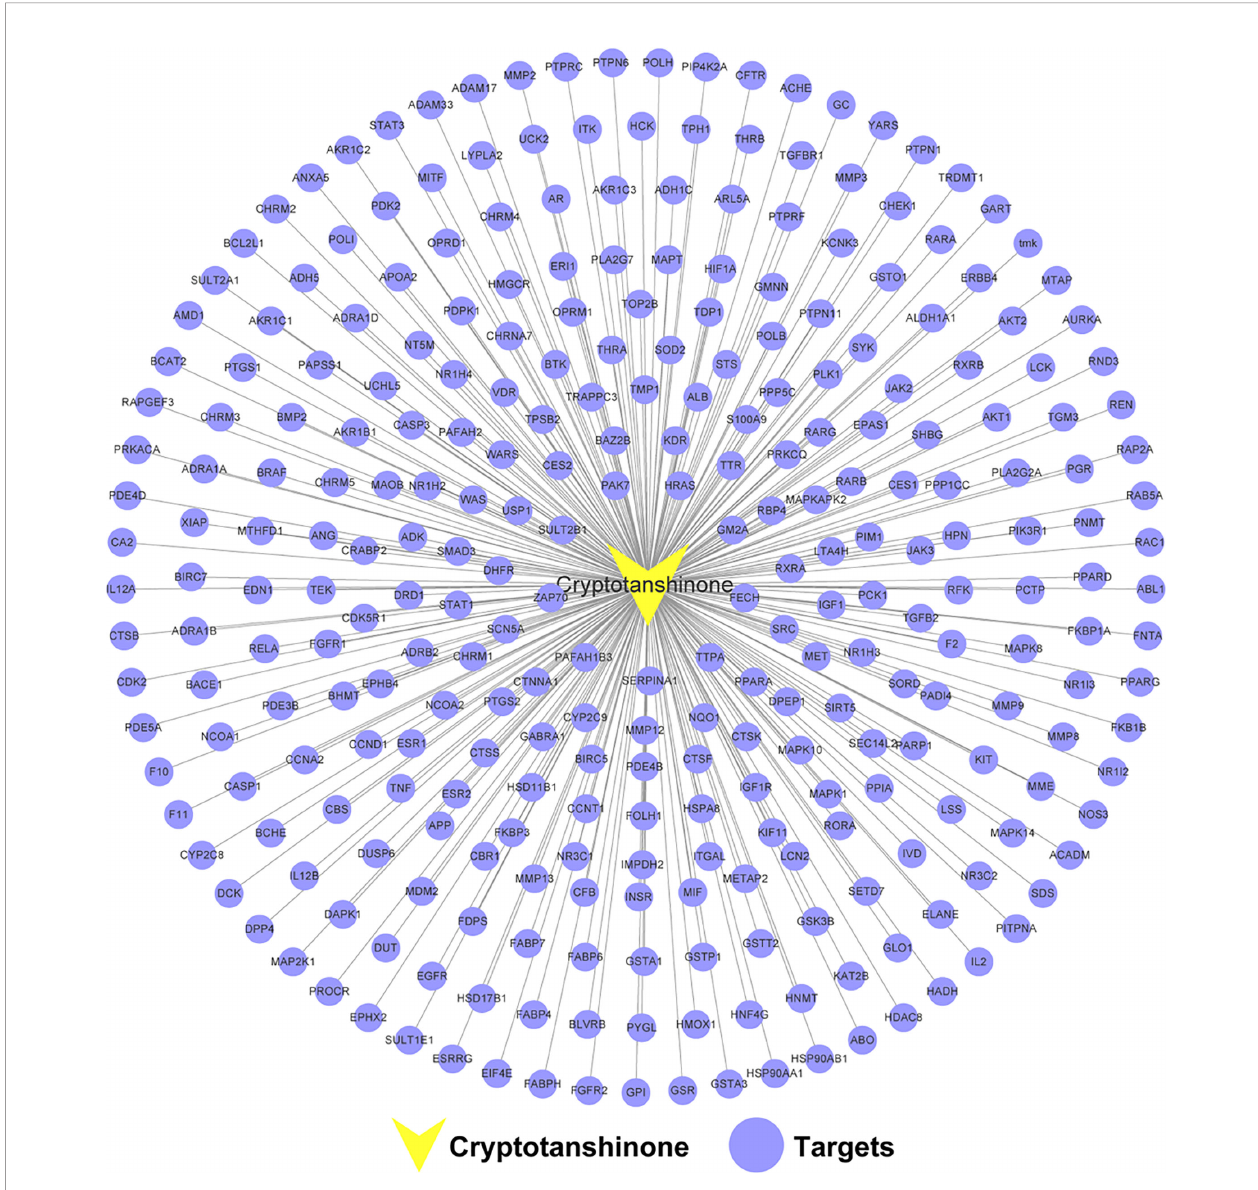
FIGURE 2 | Cryptotanshinone (CPT)-CPT target network. The network includes CPT and 296 CPT